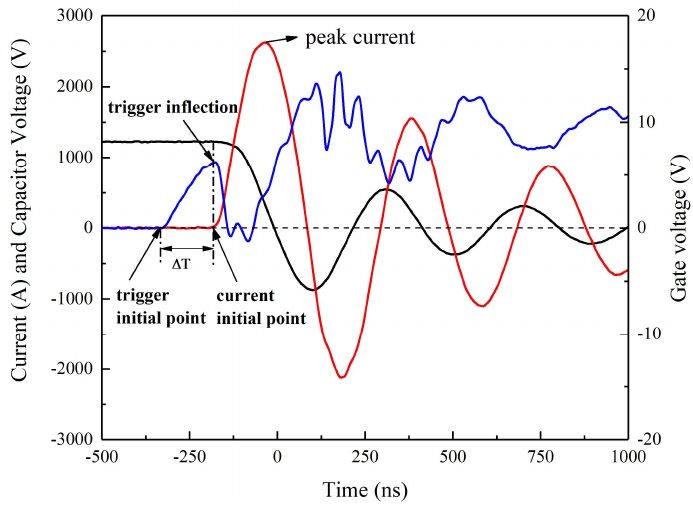
Figure 6. Curves of gate voltage, short-circuit, and capacitor at 1200 V/0.22 μF.